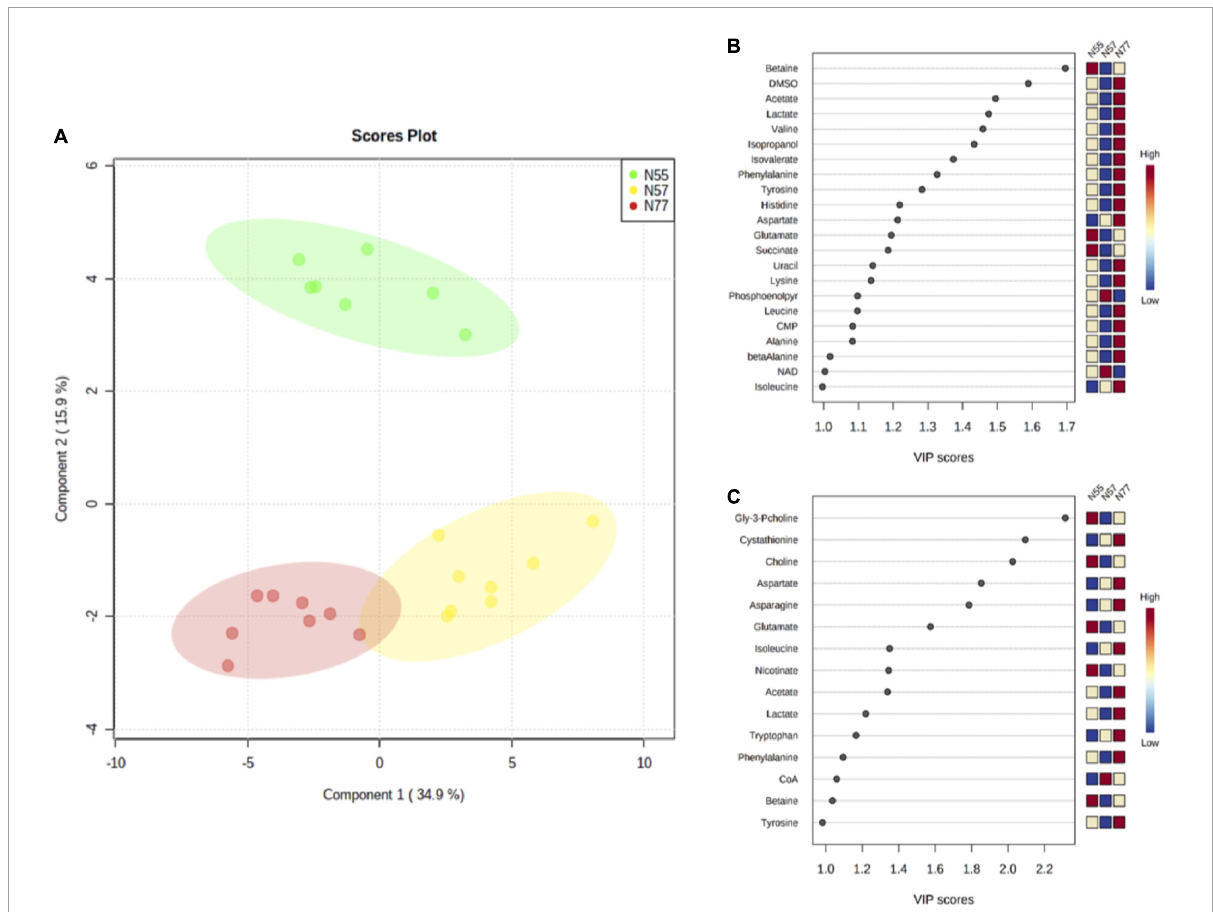
FIGURE5 PLS-DA model based on metabolites concentrations for the three pH conditions. (A) PLS-DA scores plot of first and second component, showing the discrimination between the 3 experimental conditions, N55 (green) N57 (yellow), and N77 (red) (with 5 components: R 2 = 0.97 and Q 2 = 0.92) using the metabolites levels. Metabolites that most contribute for the separation of the groups based on its VIP scores ( > 1) for (B) the first component and, (C) the second component; the colour scale presents the metabolite relative levels among the three experimental